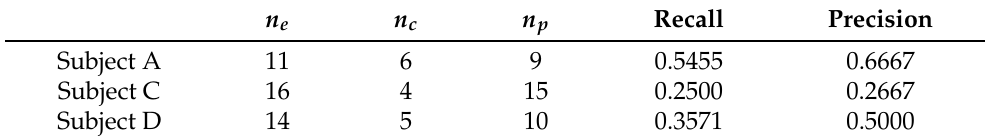
Table 10. Recall and precision from change score using FET “happiness” data of Subject Group 1. n e n c n